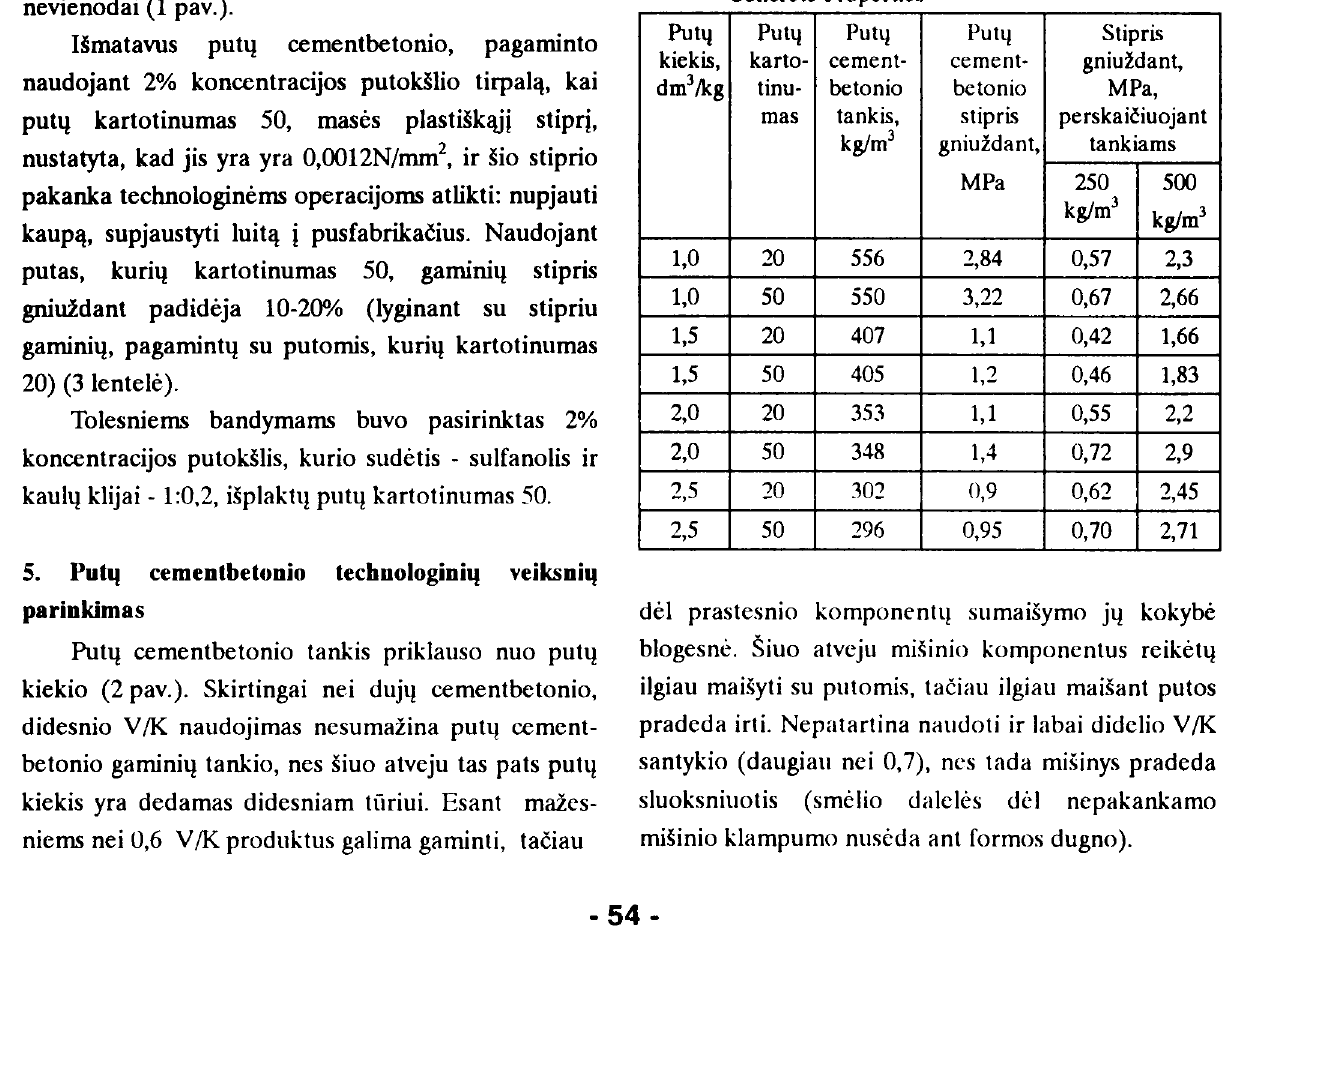
Table 3. Foam Reccurency Influence on Foam Cement Concrete